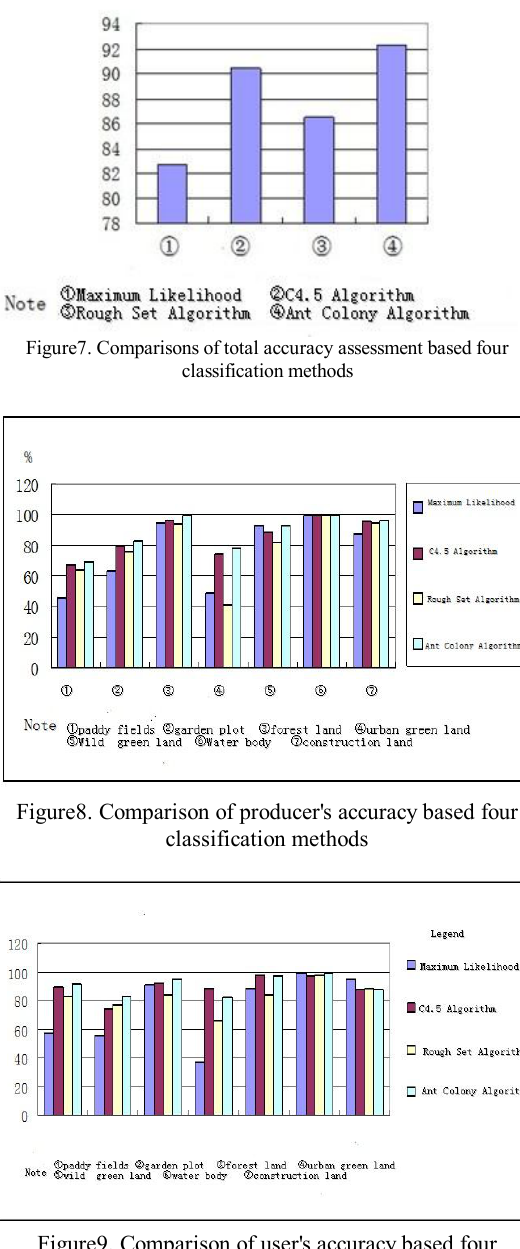
Figure9. Comparison of user's accuracy based four classification methods